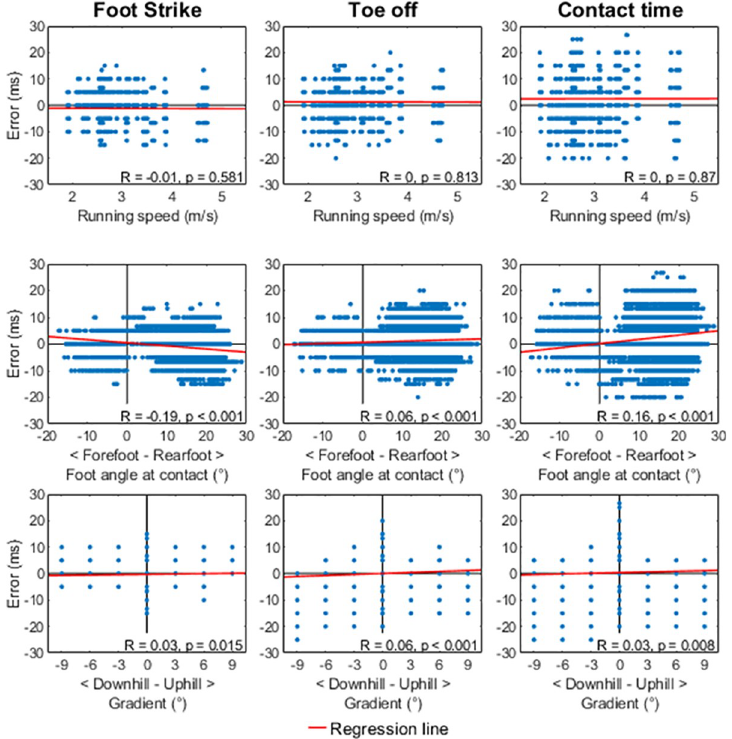
Fig 6. Correlation analyses. Scatter plots for the relation between running speed (top row), foot angle at contact (middle row) and incline (bottom row) and errors in the detection of foot-strike (left), toe-off (middle) and contact time (right) respectively. Note that only data on flat running surfaces was included for the running speed and foot angle at contact scatter plots and correlation analyses. Regression lines are included in every plot to aid visual interpretation, but line parameters and coefficient of determination are only reported in the Results section for nontrivial